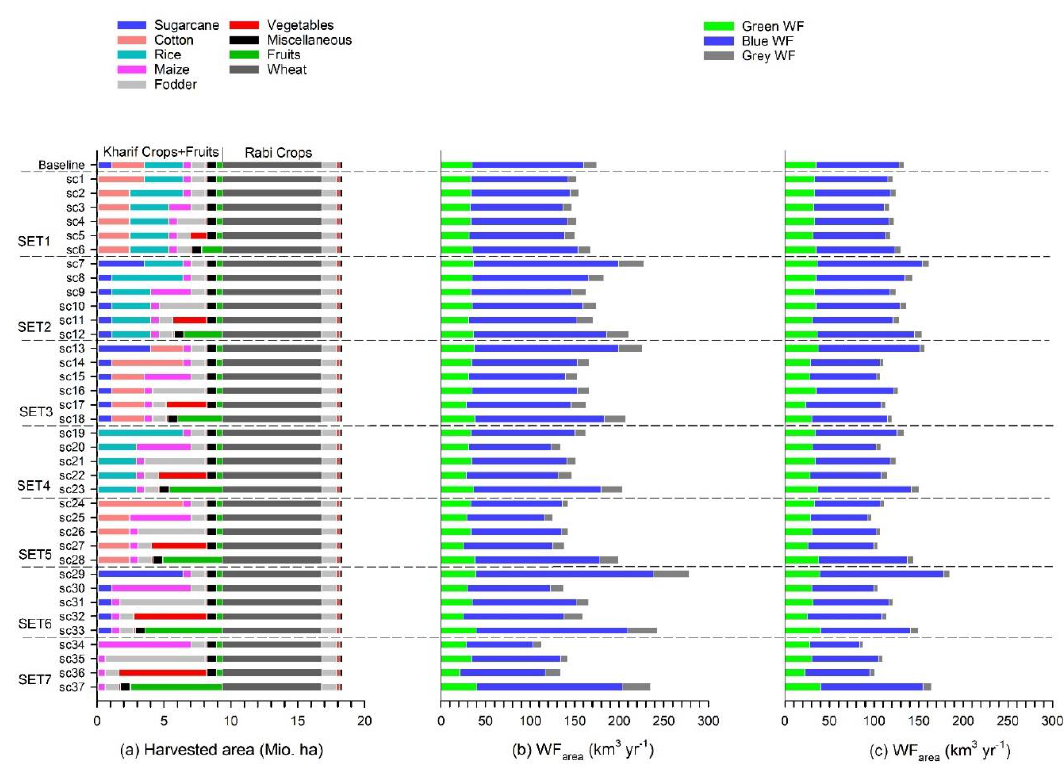
Figure 5. ( a ) Alternative cropping patterns; and ( b ) resulting WF area ; ( c ) WF area analysis of cropping pattern changes with concurrent changes in irrigation technologies.